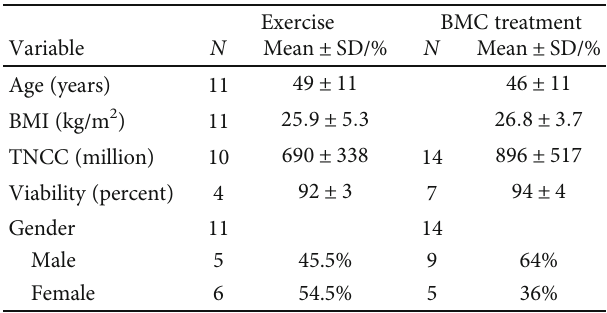
Figure 1: Flow diagram of study. ∗ Exercise therapy patients were given option to cross over to BMC treatment group any time after 3 months of therapy; therefore, some 6-month outcome data was not available. Table 1: Demographic